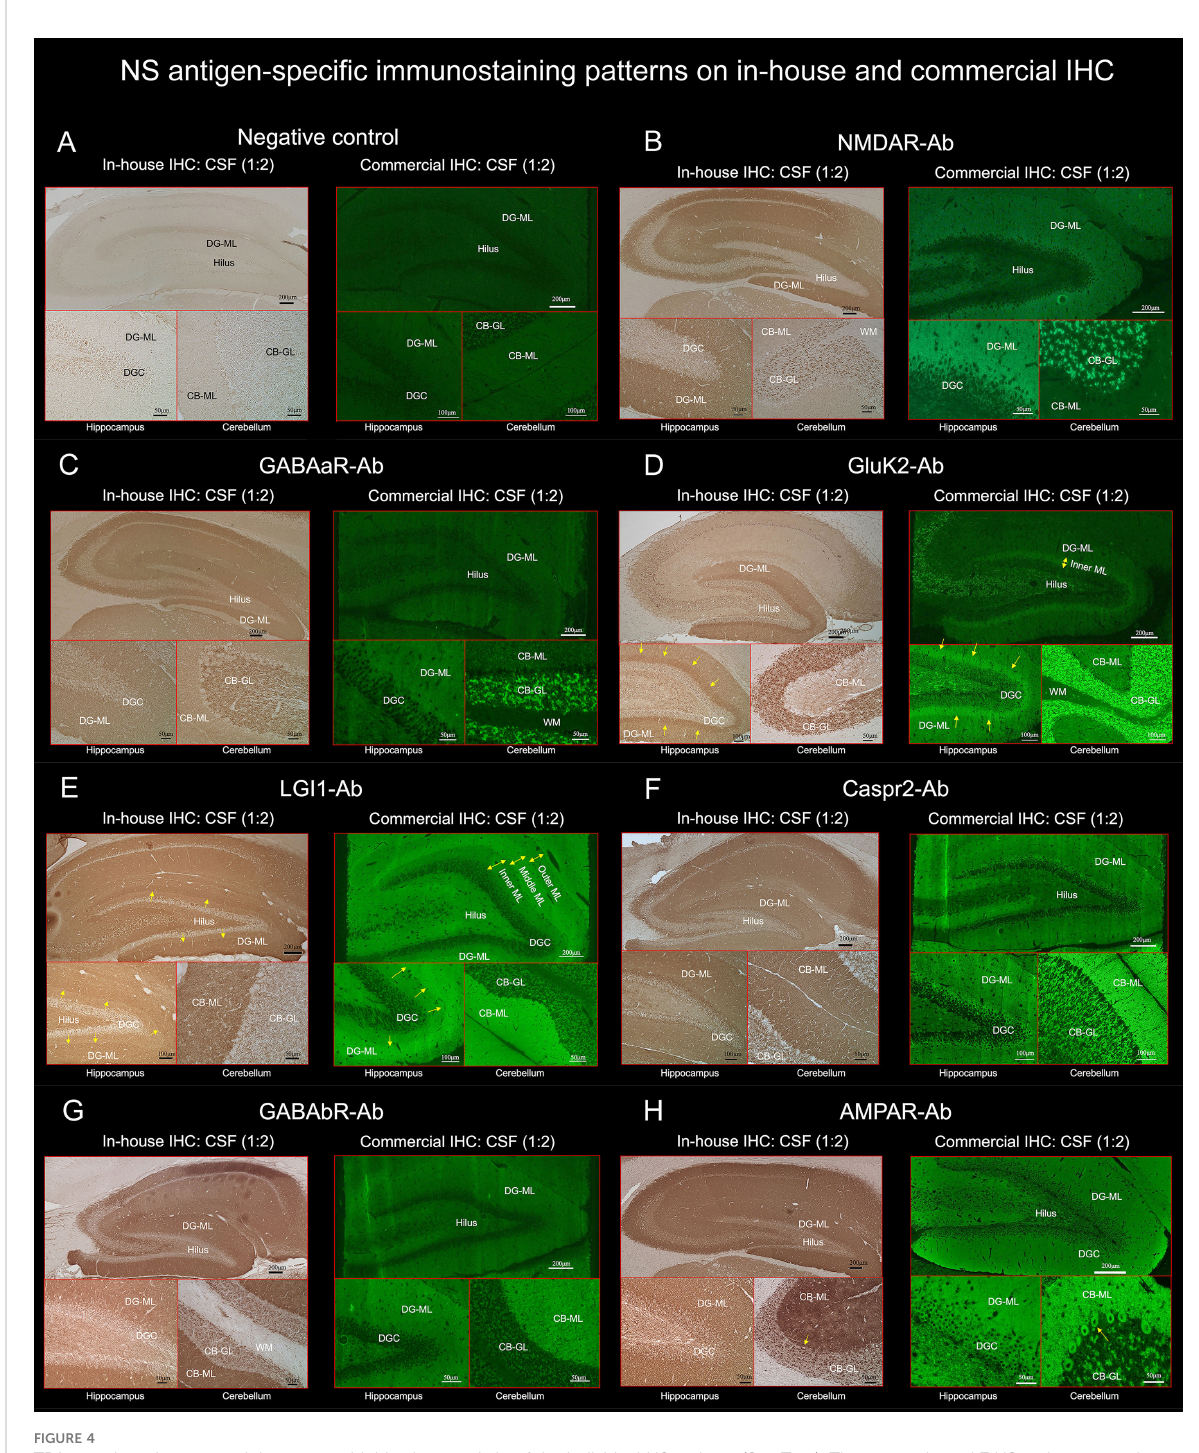
FIGURE 4 TBA reveals an immunostaining pattern highly characteristic of the individual NS antigen. (See Text). These preselected 7 NS antigens reveals intense reactivity with NS antigen “ neuropil pattern ” , among NS antigens, two reveal antigen-speci fi c laminar reactivity, along the inner layer in GluK2 ( D , arrows) and the middle layer in LGI1 ( E , arrows). The fi rst 3 NS antigens (NMDAR, GABAaR, GluK2) have dot-like reactivity on the CB- GL (B – D) , while the other 4 (LGI1, Caspr2, GABAbR, AMPAR) have homogenous reactivity on the CB-ML with some different immunoreactivity on the hilus, CB-GL, or Purkinje cells (see Text). CB-GL, cerebellar granular layer; CB-ML, cerebellar molecular layer; DGC, dentate granule cells; DG-ML, dentate gyrus molecular layer; ML, molecular layer; WM, white